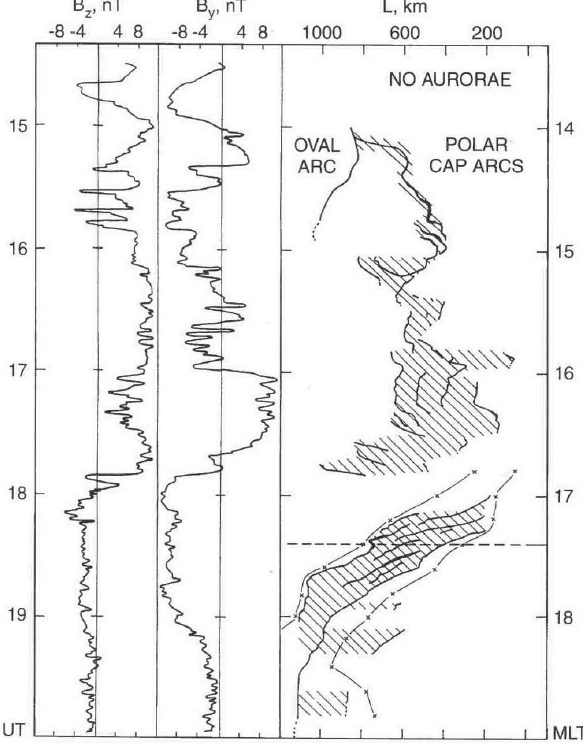
Figure 12. Variations of the B IMF z and B IMF y components obtained with the IMP-8 spacecraft and the auroral dynamics in the sky of the Vostok observatory ( 8 0 = 83 . 5 ◦ ) on 3 August 1986 (Vorobjev et al., 1995a).